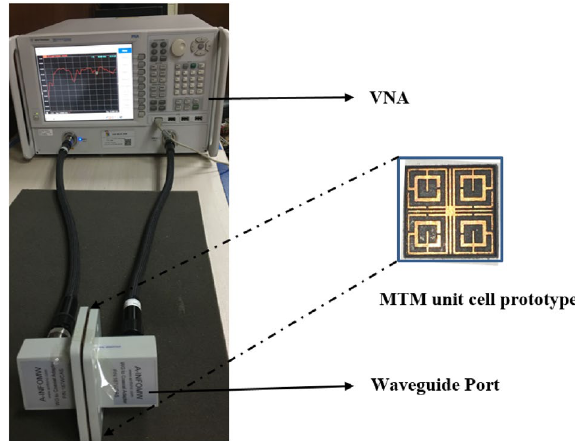
Figure 20. Experimental setup for measuring S 21 for proposed MTM.